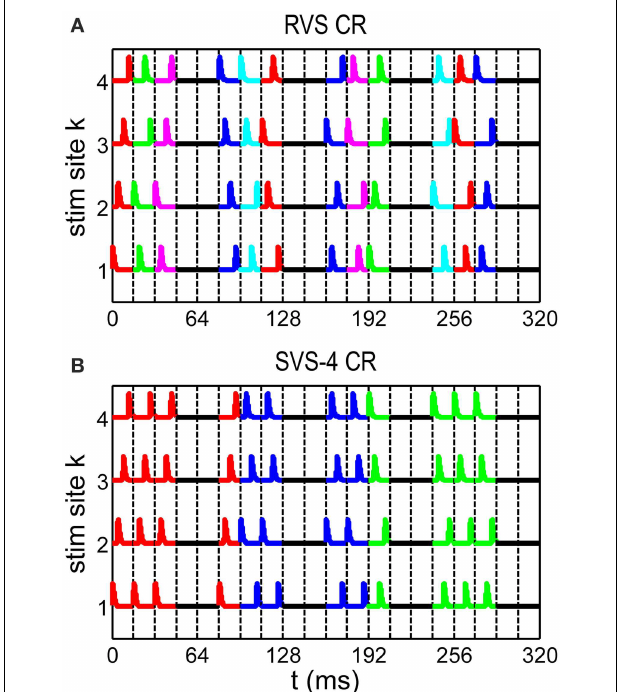
FIGURE 1 | Spatiotemporal stimulation signals of CR stimulation. (A) An example sequence order for the rapidly varying sequences (RVS) CR. (B) An example sequence order for the slowly varying sequence CR with every sequence repeated 4 times (SVS-4) before the next sequence is used. A change of color indicates a new sequence. Vertical dashed lines separate stimulation ON- and OFF cycles: three ON-cycles are followed by two